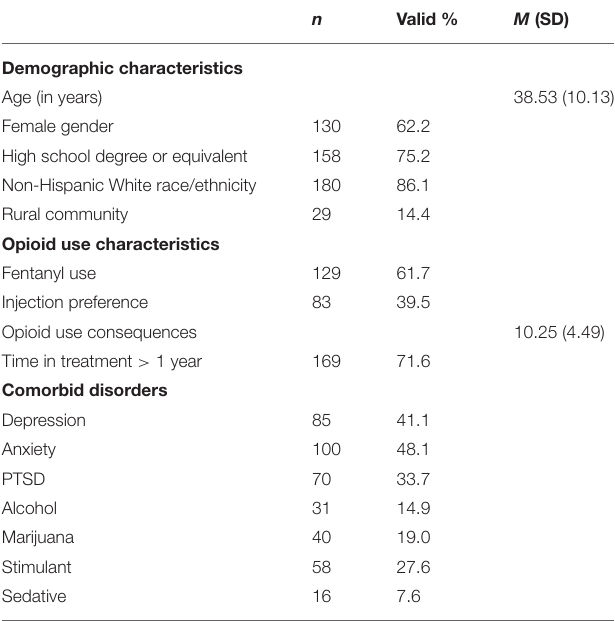
TABLE 1 | Sample characteristics ( N =